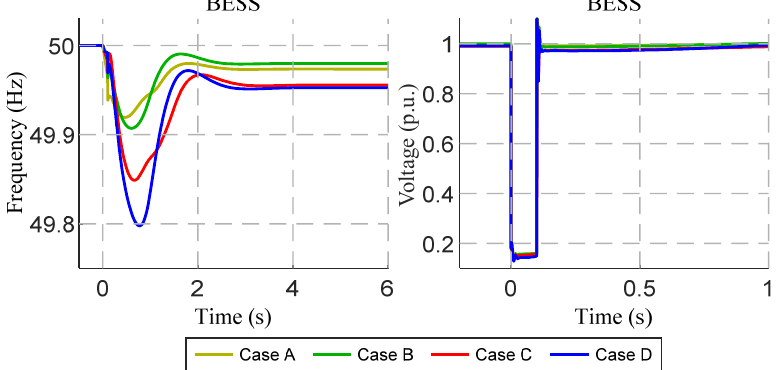
Figure 24. BESS power converter synthetic frequency and terminal voltage with different IM load percentages.